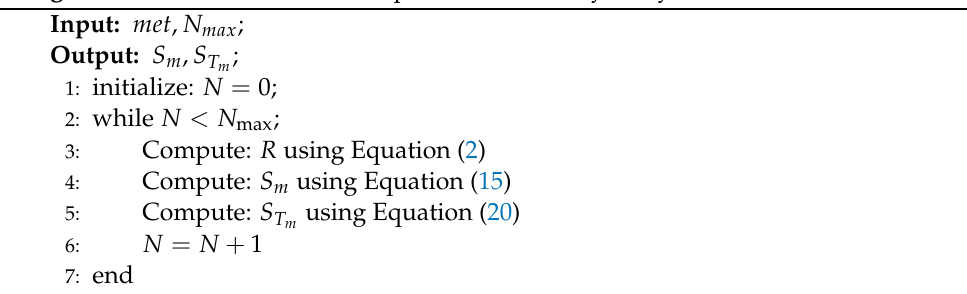
Algorithm 1: Pseudocode for tau-p model sensitivity analysis.